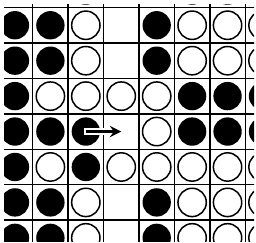
Figure 53. BLACK intrudes.